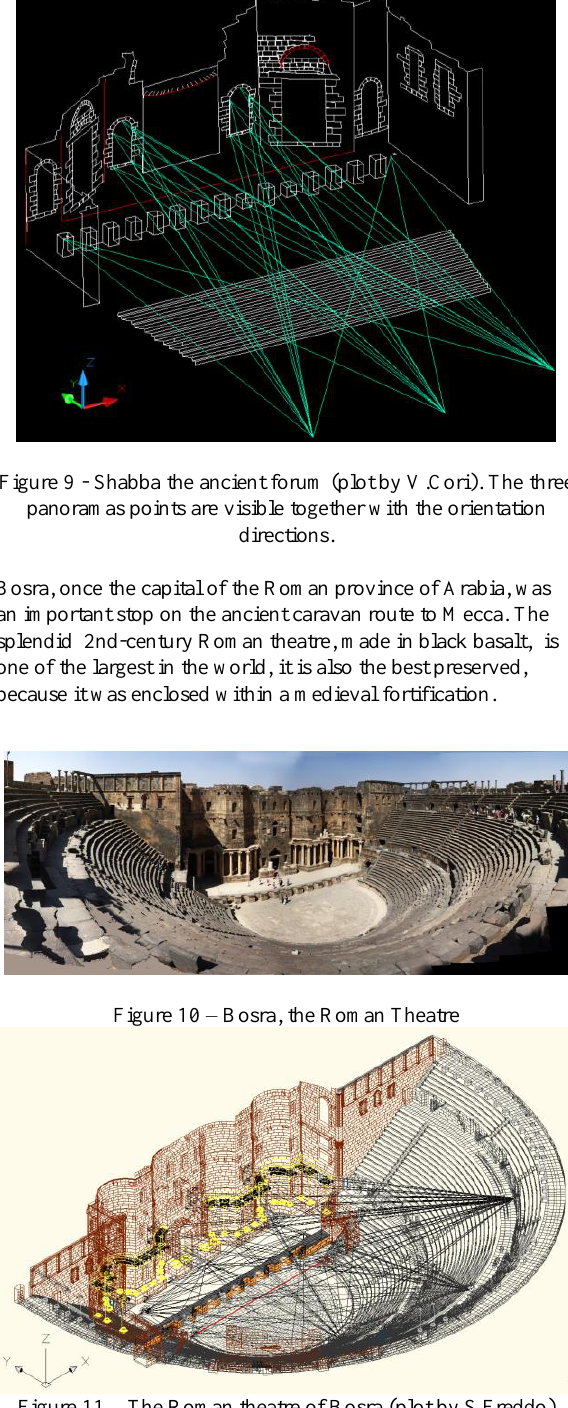
Figure 5 - Al Sybahieh Mosque (plot. By G.Merlonetti with